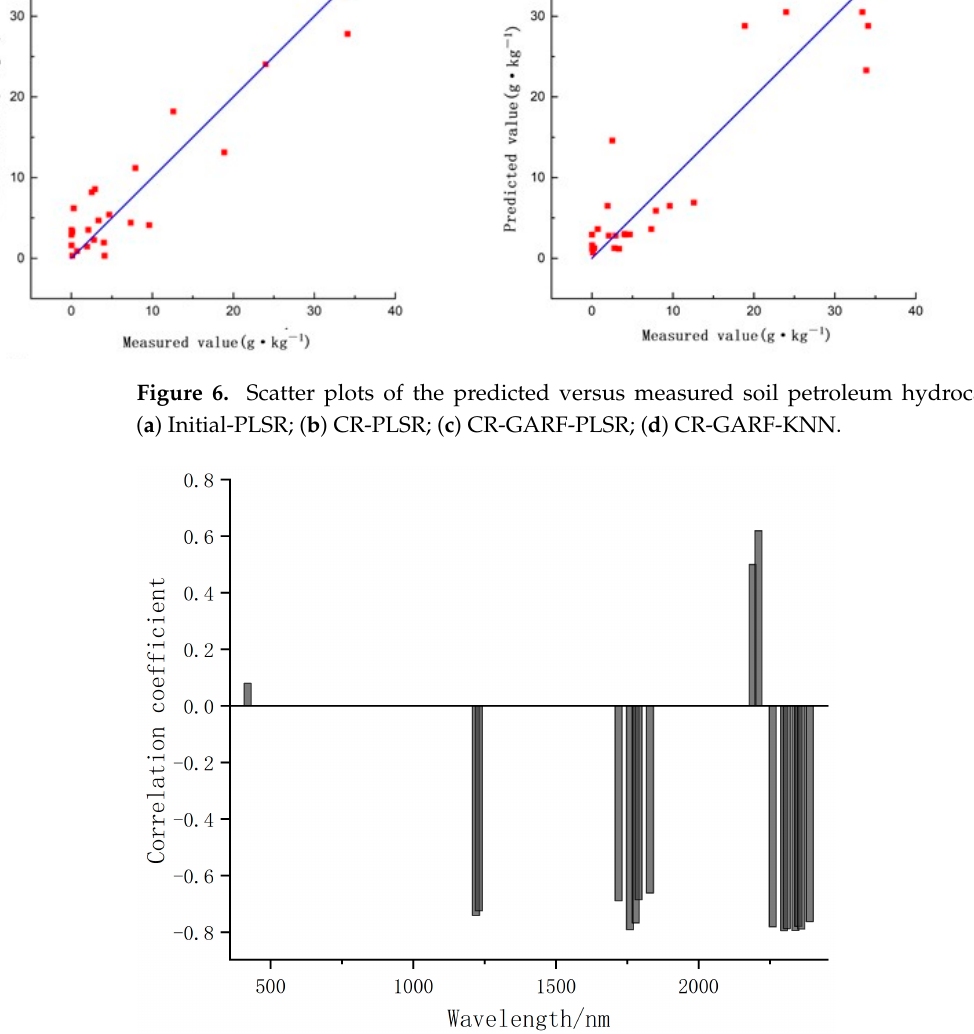
Figure 7. Correlation coefficient between soil petroleum hydrocarbon content and CR-GARF optimal characteristic bands.